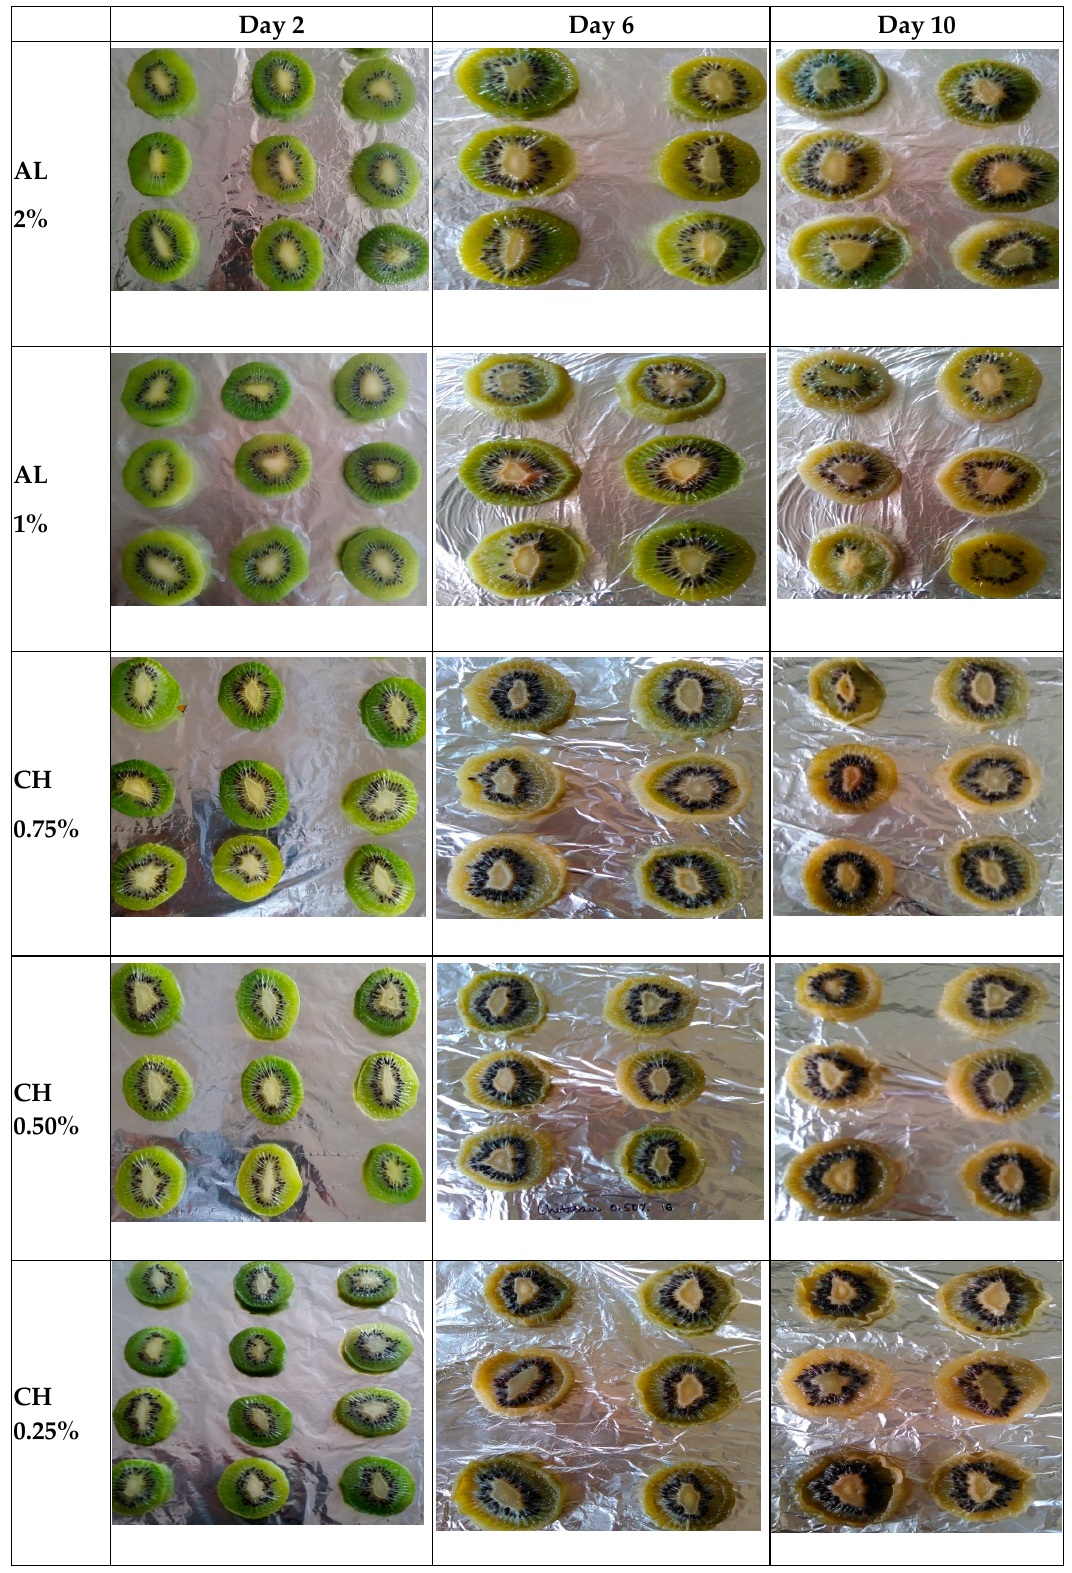
Figure 2. Changes in the appearance of polysaccharide ‐ based coated kiwi fruit slices during